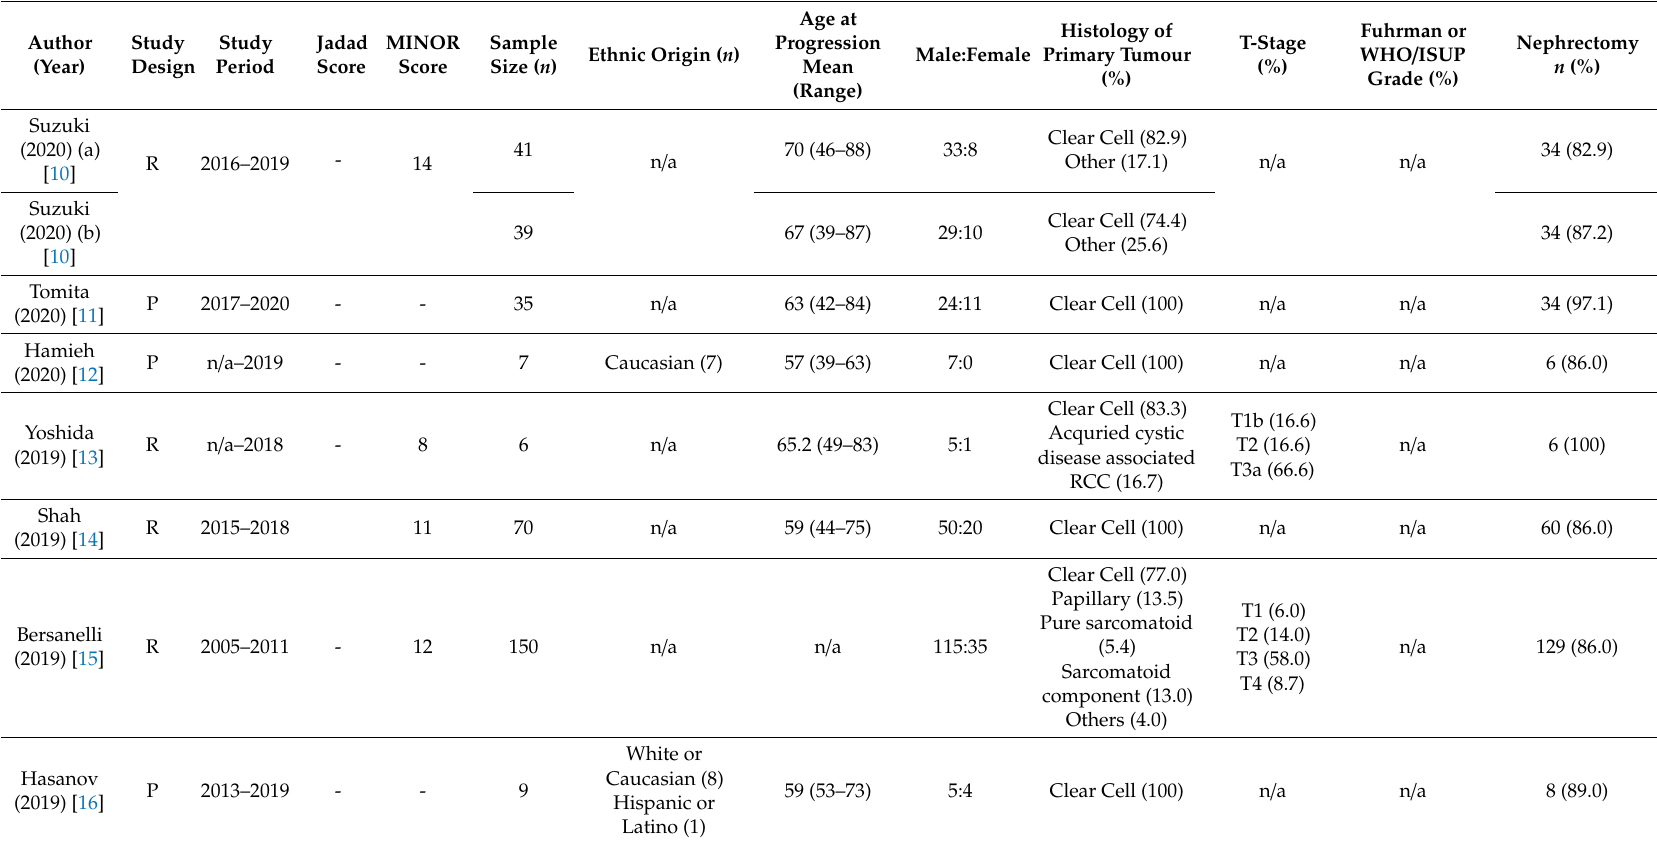
Table 1. Patients’ demographics and tumor